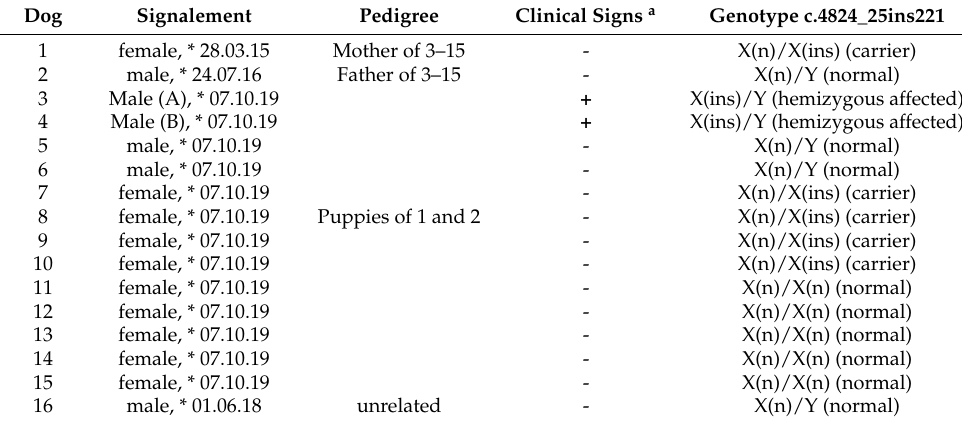
Table 2. Phenotype and genotype distribution in study